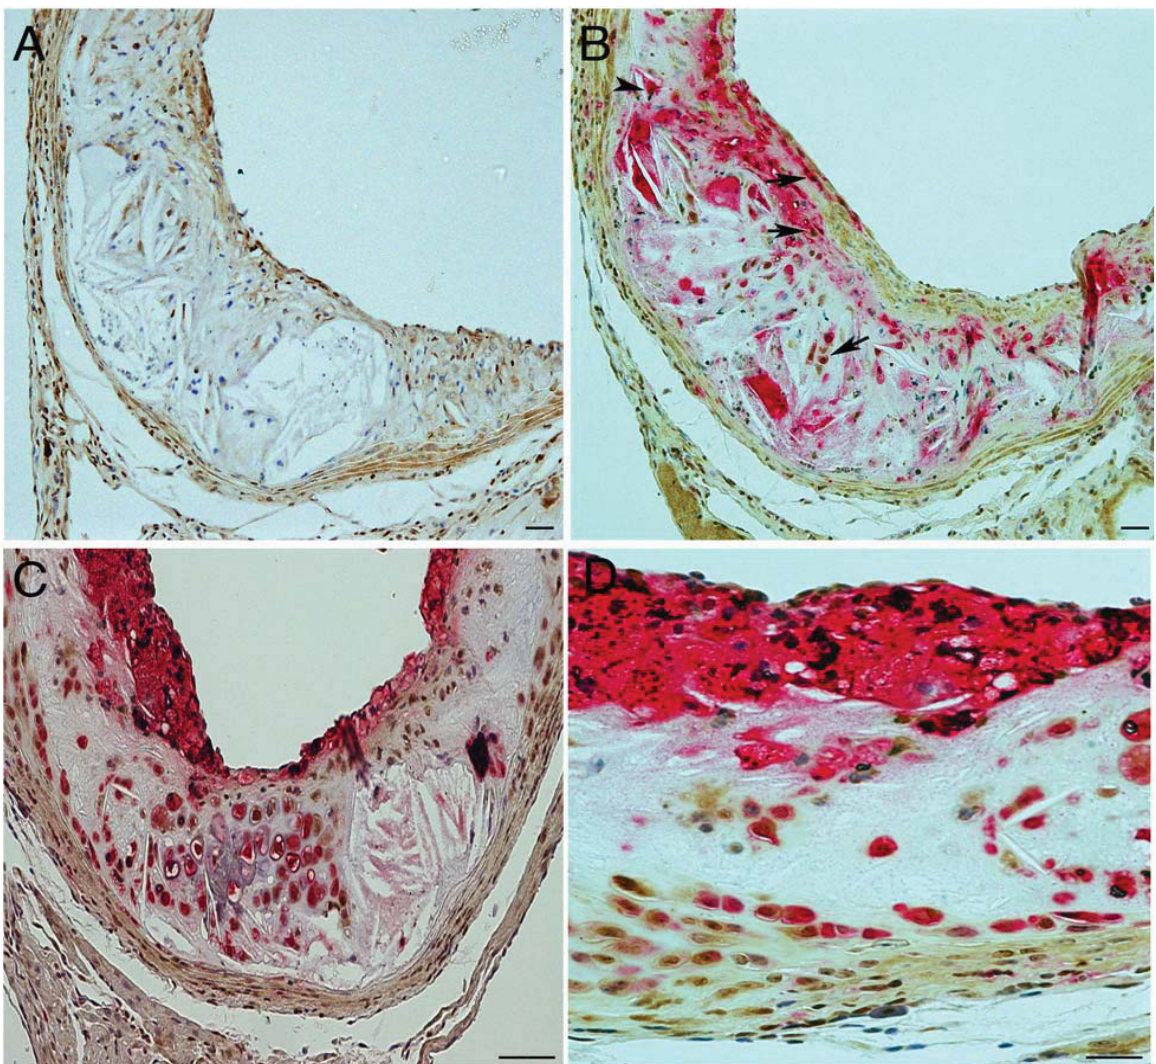
Figure 2. Tribbles 1 expression in macrophages in experimental mouse atherosclerosis. A Single immunostaining for trb-1 (brown) in a section from the aortic sinus, B Dual immunostaining of a serial section to A for trb1 (brown) and macrophages (Gal3, red), note areas of plaque stained red; trb-1 expressing macrophages are denoted by arrows. C and D , high power images of other representative plaques showing most macrophages stain positive for trb-1 in fat-fed ApoE deficient